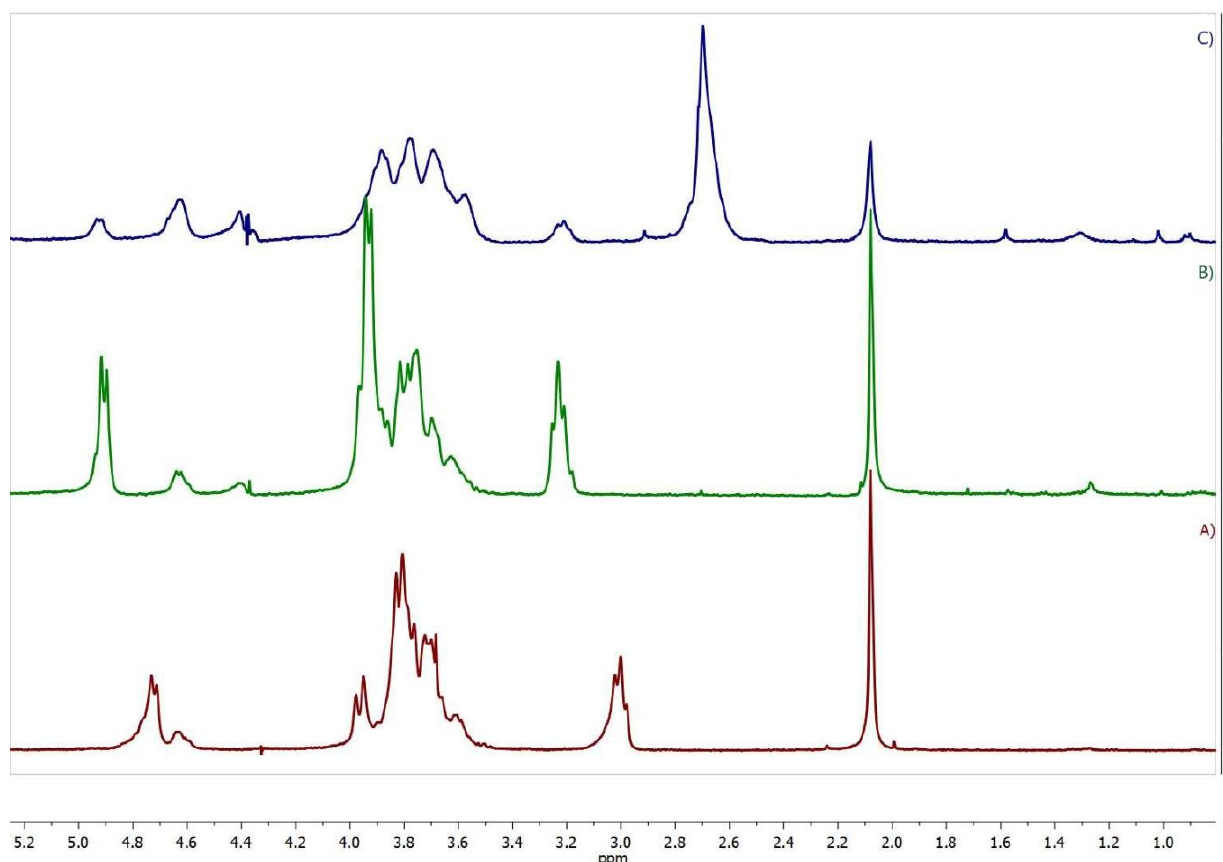
Figure 2. 1 H NMR spectra (400 MHz, D 2 O/trifluoroacetic acid) of ( A ) CS, ( B ) CS-DEX-10, and ( C ) SucCS-DEX-10.